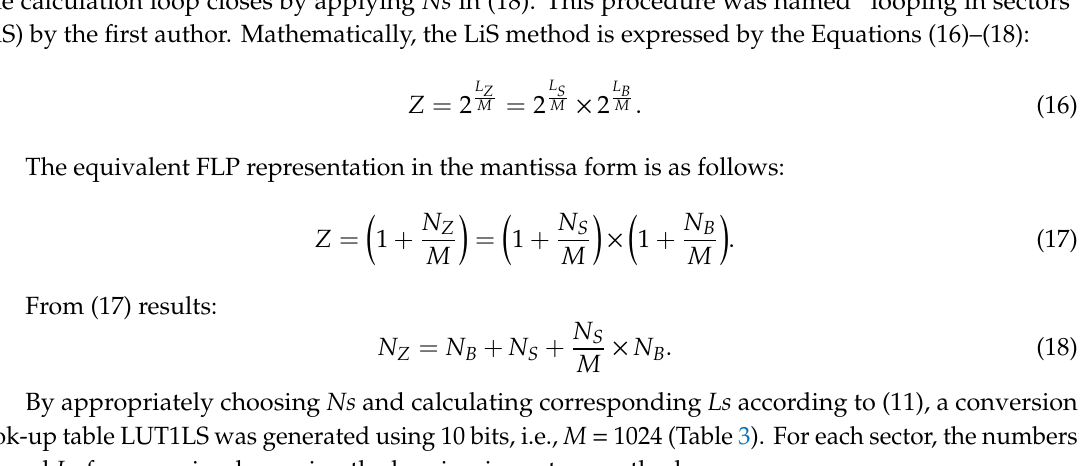
Figure 2. Looping in sectors: conversion from L Z to N Z for 𝑀 = 1024 .